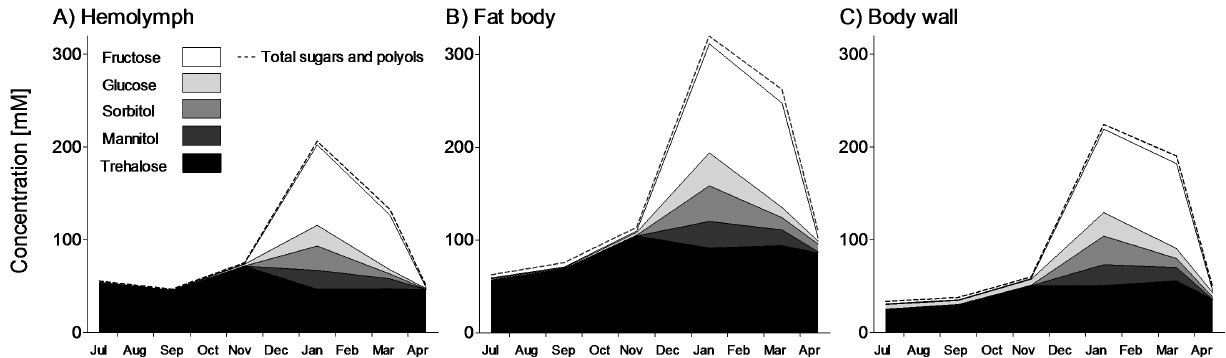
Figure 3. Sugars and polyols. Seasonal changes in concentrations of selected sugars and polyols in hemolymph (A), fat body (B), and body wall (C) of field-sampled caterpillars of Cydia pomonella during 2010/2011. The areas showing concentrations of individual compounds are stacked and the total concentration of all sugars and polyols is shown as a broken line. See Dataset S1 for details.